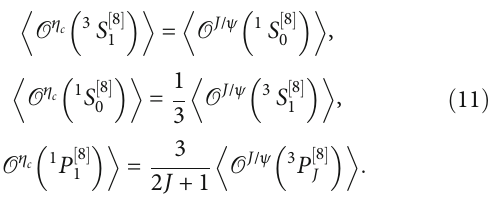
Figure 3: The LHCb [100] measurements for prompt η evaluated with three di ff erent LDME sets from Refs. [77, 79, 80]. Figures taken from Ref.